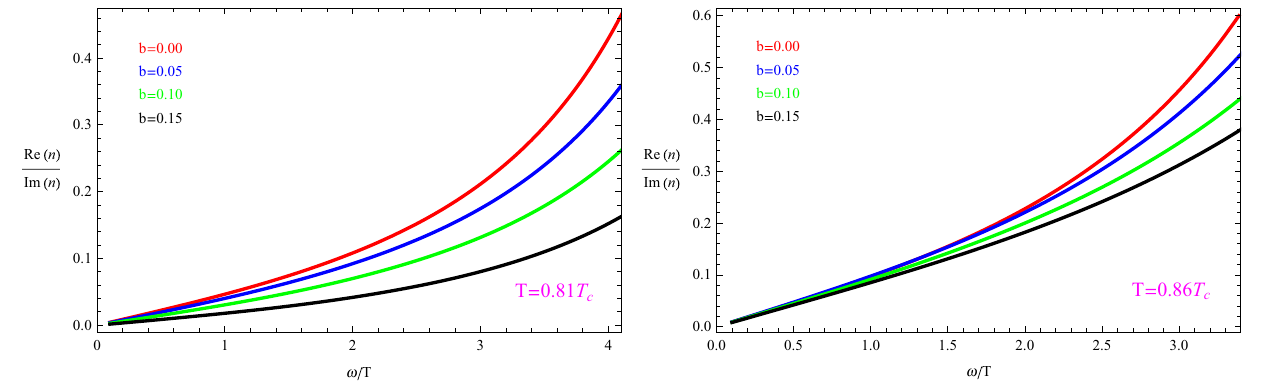
Fig. 6 The ratio Re ( n )/ Im ( n ) as a function of ω/ T with the fixed temperatures T = 0 . 81 T c (left) and T = 0 . 86 T c (right) for different values of the Born–Infeld parameter b . The four lines in each panel